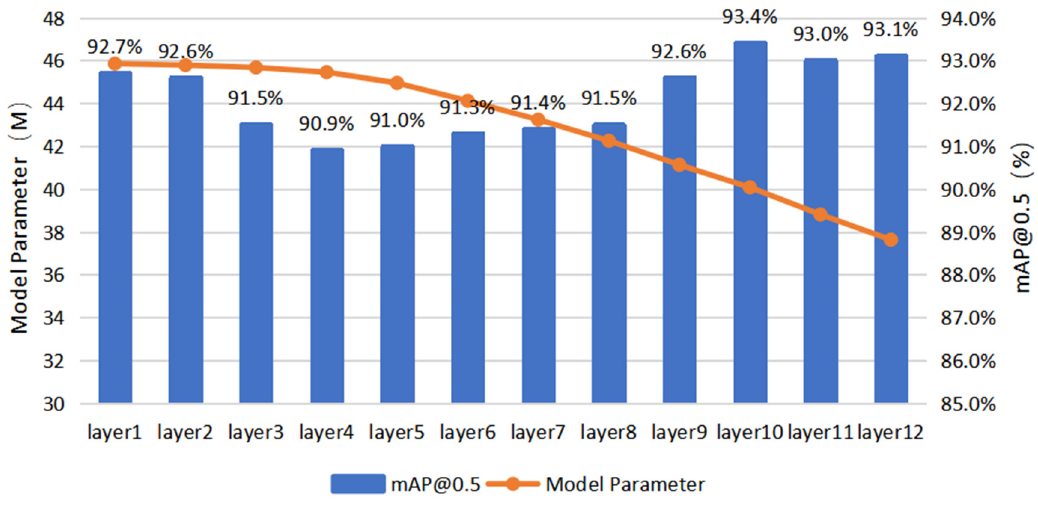
Figure 9. Pruning the Swin-T YOLOX model identification accuracy, model parameters and their changes at each layer of the Swin Transformer.